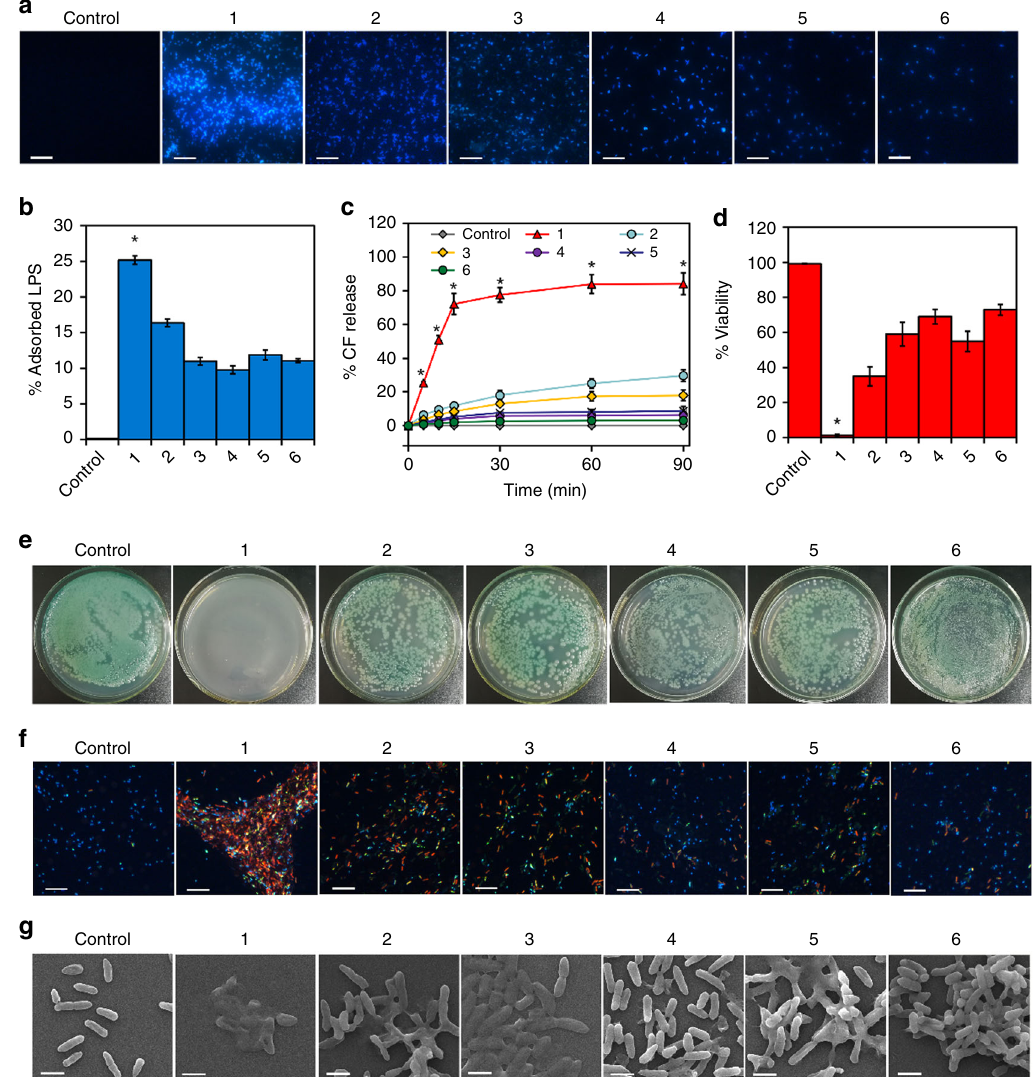
Fig. 5 Binding-related antibacterial activity of the six designed metallacycles. a Bacterial adsorption of the P. aeruginosa cells (stained by 4 ′ ,6-diamidino- 2-phenylindole (DAPI)) by the metallacycles on glass surfaces (Scale bar = 10 μ m). b Adsorption activity of the metallacycles with the bacterial liposaccharides. c Liposome damage activity of the metallacycles. The released fl uorescence dye CF from the liposomes indicates damage of the liposomes caused by the metallacycles. d Bacterial viability revealed by CFU assays with the molecular concentration of 8 μ M. e Growth of the treated P. aeruginosa cells on the Luria – Bertani (LB) medium plates. f Confocal images of the DAPI-propidium iodide (PI) double-stained P. aeruginosa cells (Scale bar = 10 μ m). The PI-positive (red) cells indicated the dead cells. Noting that the molecular necklace 1 strongly bound the bacterial cells and induced bacterial aggregation, leading to severe cell death. g SEM images of the treated cells (Scale bar = 1 μ m). Noting that the molecular necklace 1 strongly bound the bacterial cells and induced cell collapse. Data are represented as mean ± SD ( n = 3). Asterisk (*) indicates signi fi cant difference between the molecular necklace 1 group and the other groups ( P <